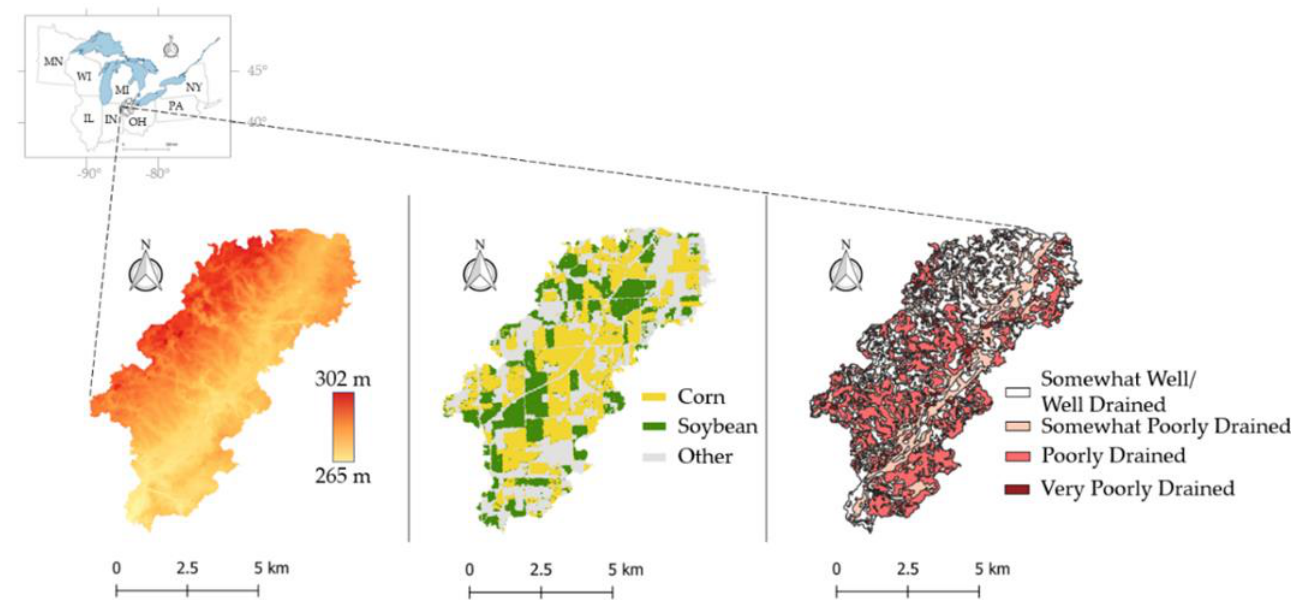
Water 2021 , 13 , x FOR PEER REVIEW 4 of 23